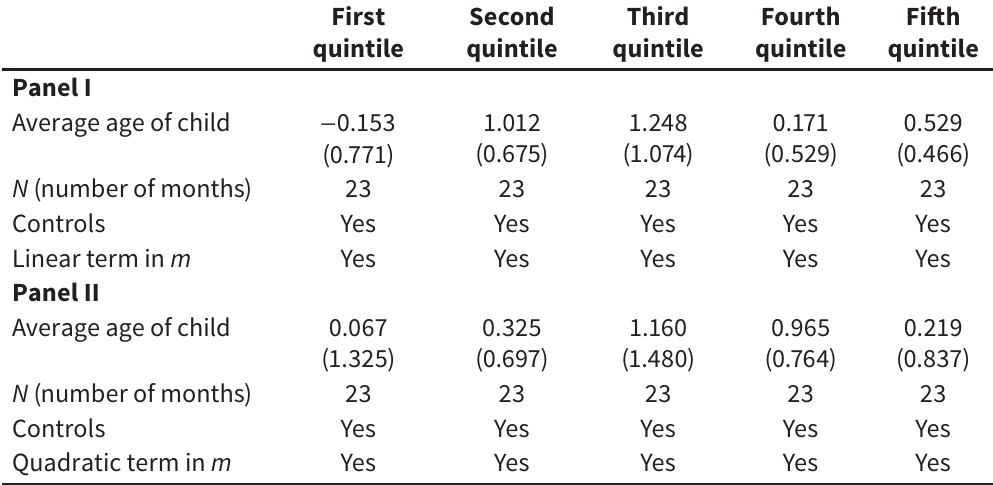
Average age of the child when the mother returned to work, by income quintile